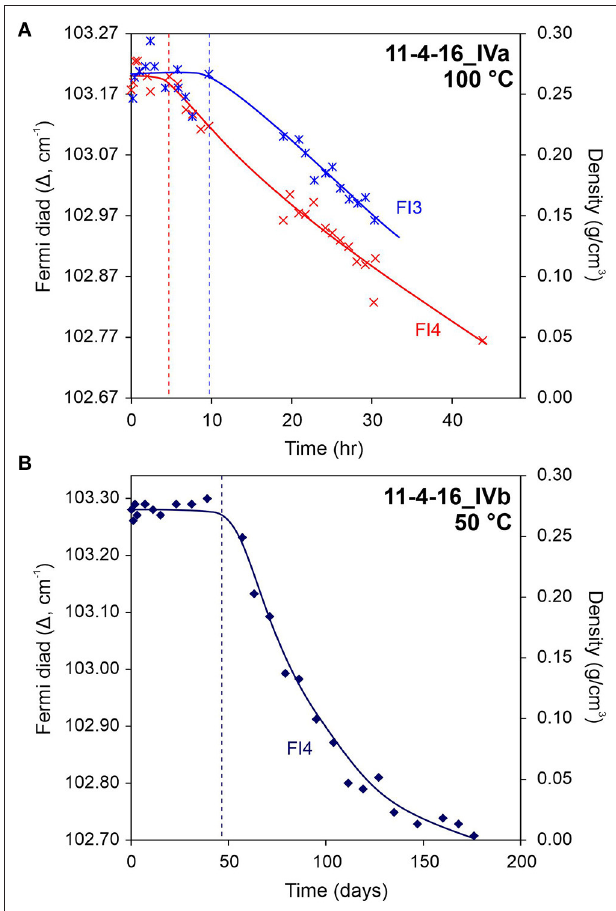
FIGURE 4 | Variation in Fermi diad splitting and CO 2 density during the reaction of olivine with CO 2 at 100 ◦ C ( A ; sample 11-4-16_IVa) and 50 ◦ C ( B ; sample 11-4-16_IVb). All fluid inclusions initially contained ∼ 20 mol% CO 2 . Dashed lines indicate the elapsed time from the beginning of the experiment at which the change in Fermi diad splitting (density) became large enough to detect and monitor by Raman to follow the reaction.